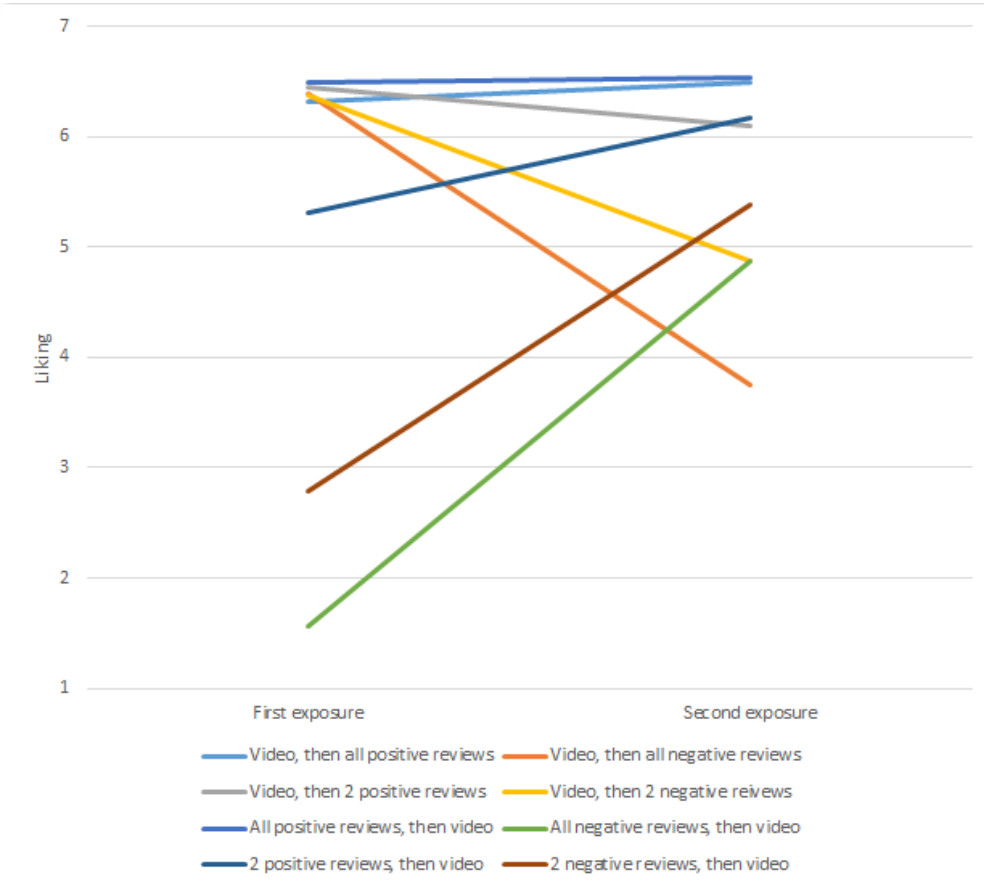
Figure 1. Interaction effect between content viewing order and valence of